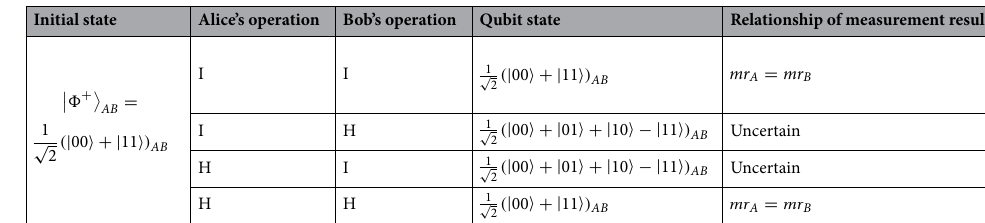
Table 4. Relationship between Bell states and Hadamard